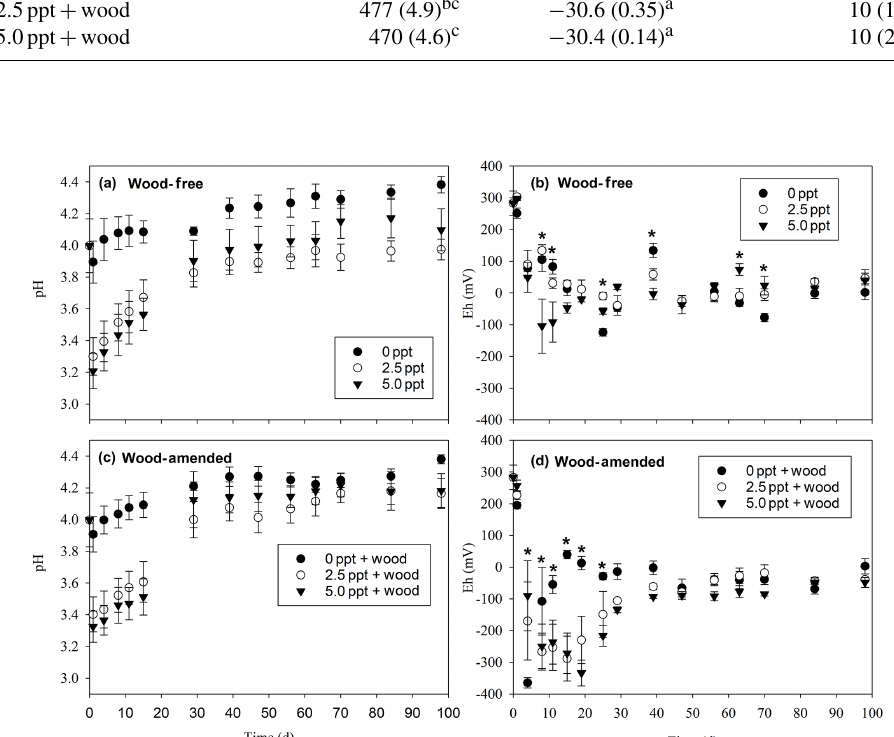
Figure 2. pH for wood-free soils (a) and wood-amended soils (b) and redox potential for wood-free soils (c) and wood-amended soils (d) measured over the course of the 98d laboratory incubation. Symbols represent the mean with standard error ( n = 4). An asterisk ( P < 0 . 05) indicates significant differences between treatment means at each time